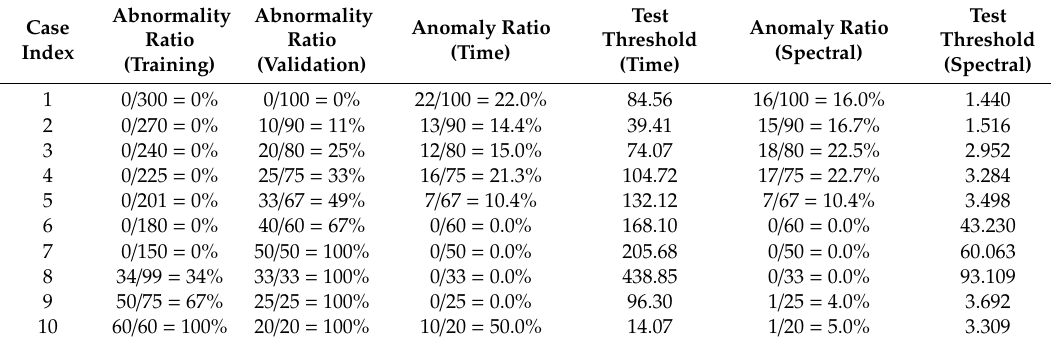
Table 9. The e ff ects of abnormality ratio to the anomaly ratio and the test thresholds of time series and spectral analysis